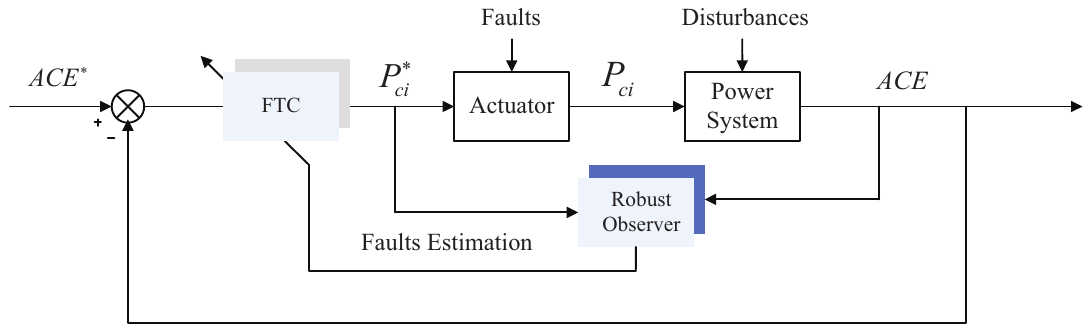
Figure 4. The schematic diagram of the proposed FTC design for the multi-area power